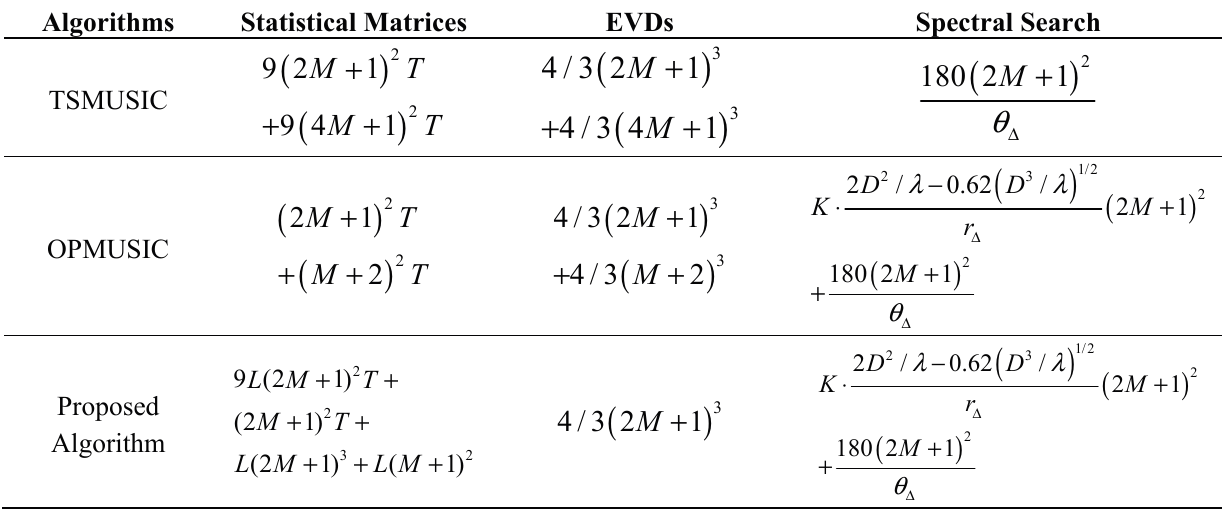
Table 1. Computational complexity